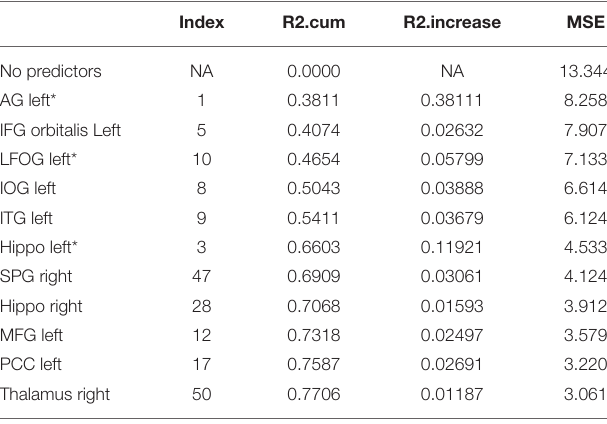
TABLE 5 | Results from a stepwise regression with the brain areas as predictors, and Trial 4 as the depended variable.